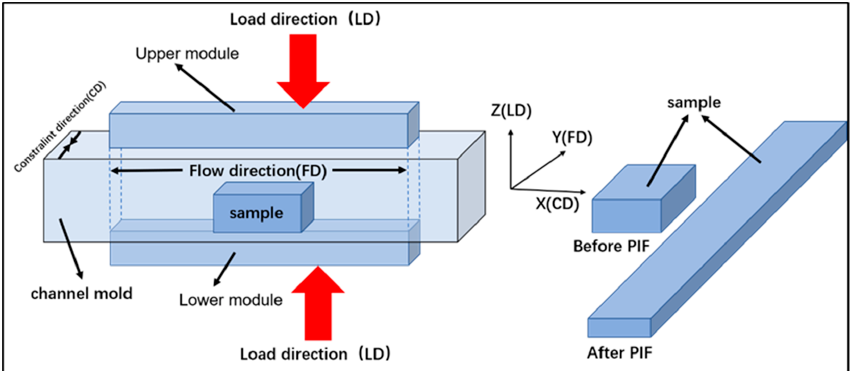
Figure 1. Pressure-induced-flow (PIF) process schematic .